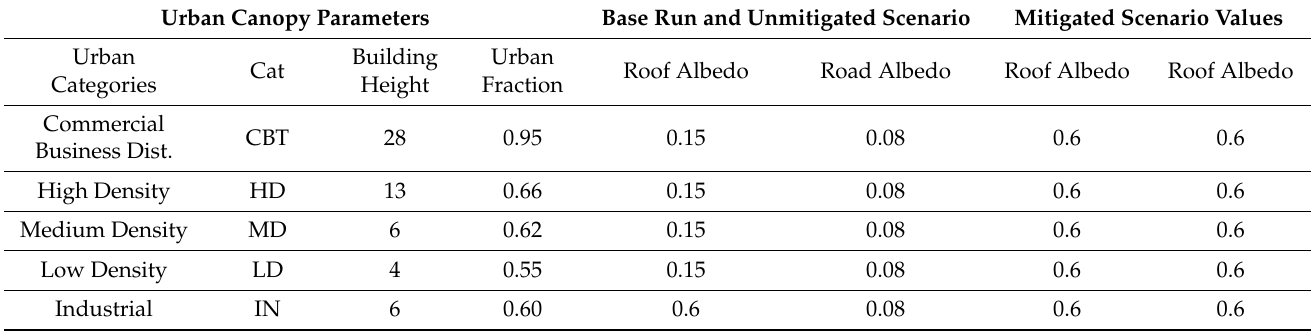
Table 8. Basic Values of the urban configuration used for the base run and mitigation simulations.